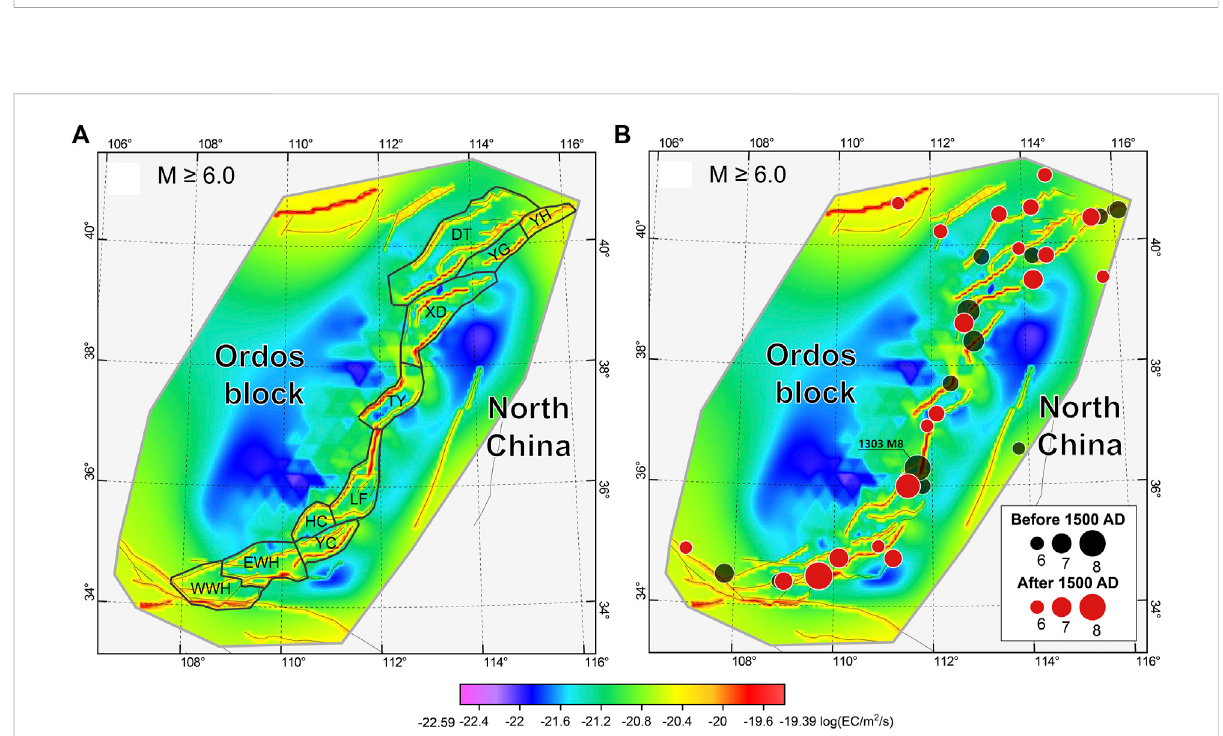
FIGURE 12 (A) The forecast of shallow seismicity rate (in epicenters per square meter per second) in the FWRZ for a threshold M 6.0, evaluated on a 0.0625 ° ×0.0625 ° grid. The black polygonal areas represent the partition boundaries used to count seismicity. Abbreviations are: WWH, the Western Weihe Basin; EWH, the Eastern Weihe Basin; YC, the Yuncheng Basin; HC, the Hancheng Basin; LF, the Linfen Basin; TY, the Taiyuan Basin; XD, the Xinding Basin; DT, the Datong Basin; YG, the Yuguang Basin; YH, the Yanhuai Basin. (B) Consistent with (A) ,the red and black dots represent the epicenter distribution of historical earthquake occurred in the FWRZ before and after 1,550,